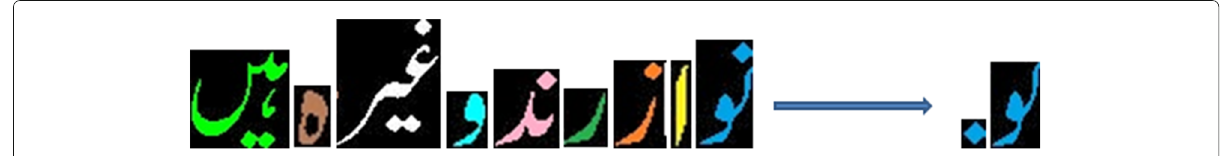
Fig. 12 Text line segmented as complete ligatures showing sample separation into primary and secondary ligatures